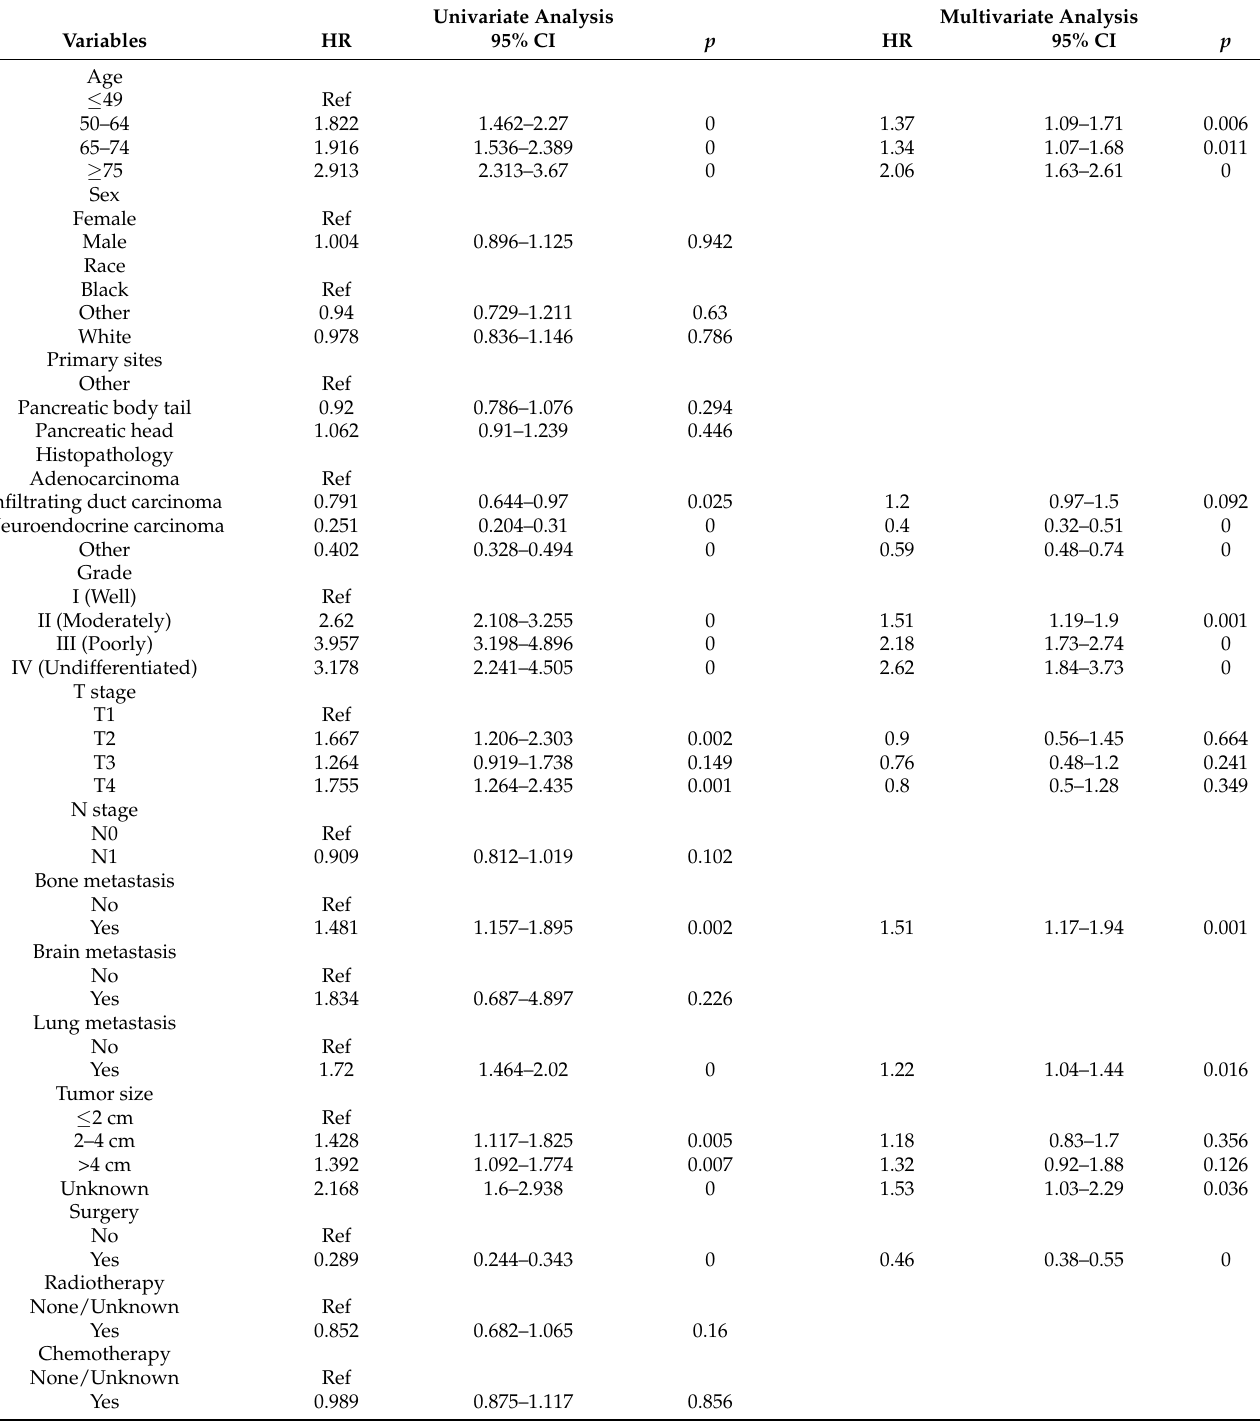
Table 4. Univariate and multivariate Cox regression models for overall survival in patients of pancreatic cancer with liver metastases. Univariate Analysis Multivariate Analysis